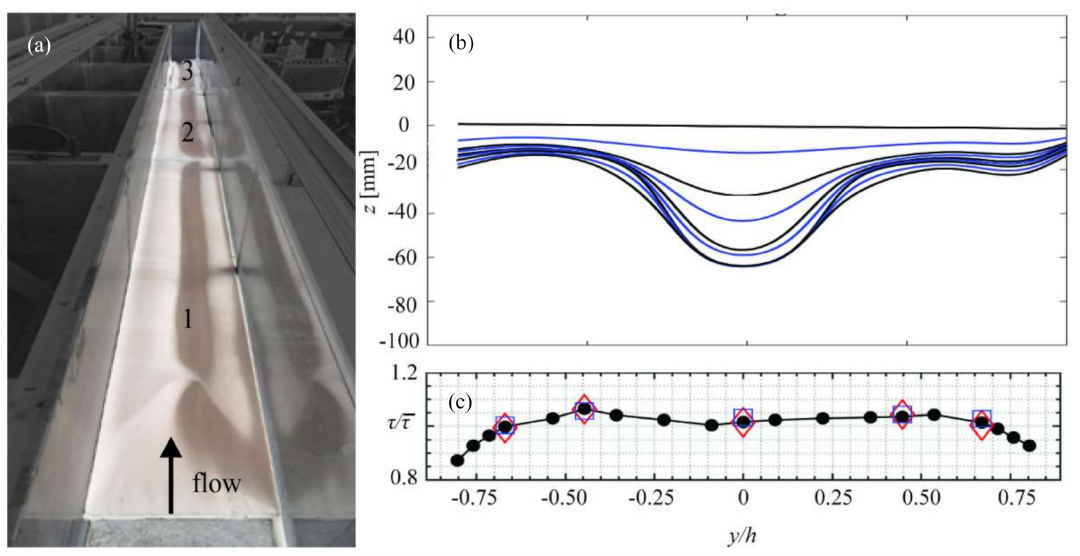
Figure 13. ( a ) Photo of the abraded bed after the test with h o = 10 cm, F o = 3, Q s = 100, 200, 400, 700 g / s and D m = 7.2 mm (1, 2 and 3 refer to high-, medium-, and low-strength foams, respectively), ( b ) Cross-sectional profile development on medium-strength foam at certain time steps, total run